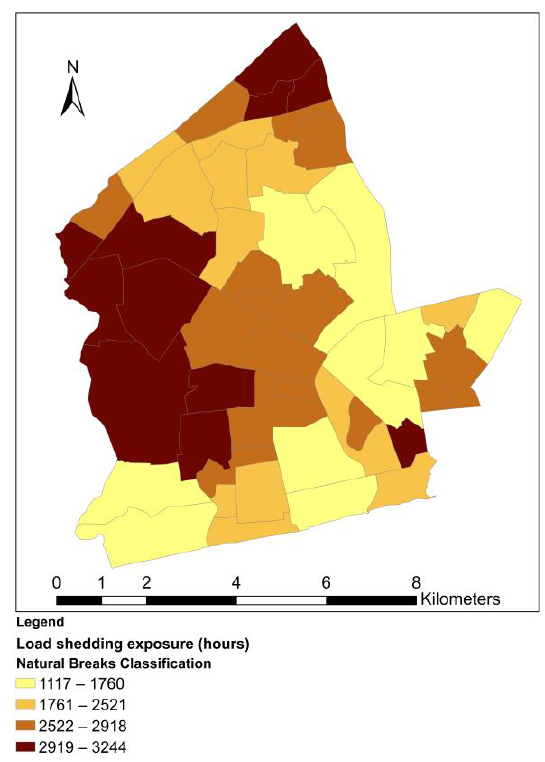
Figure 3. Neighborhood exposure to electricity load shedding.